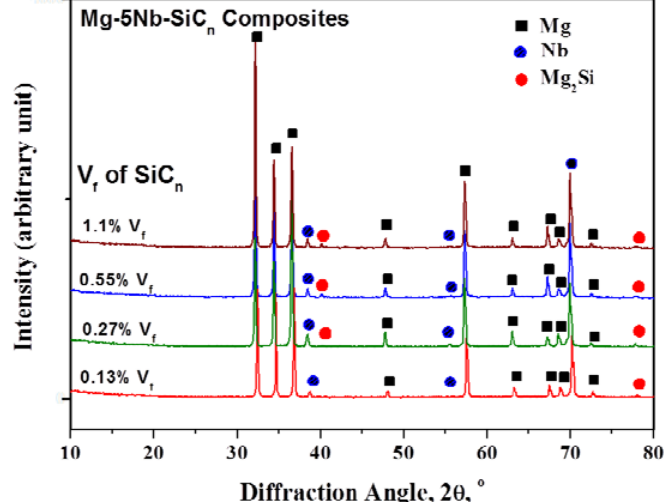
Figure 4. X-ray diffraction patterns of the developed Mg-5Nb-SiC